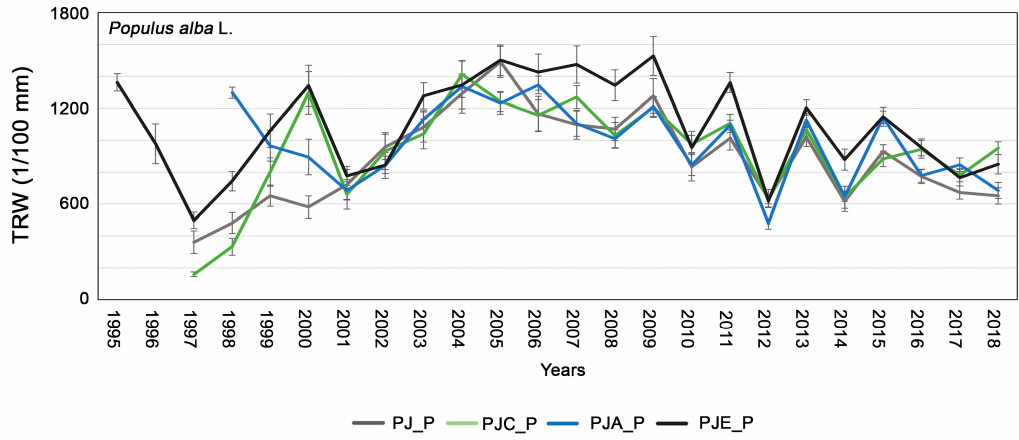
Figure 2. Average tree-ring chronologies of Populus alba in the different systems: PJ_P in gray; PJC_P in green; PJA_P in blue; PJE_P in black. The bars indicate the standard error.